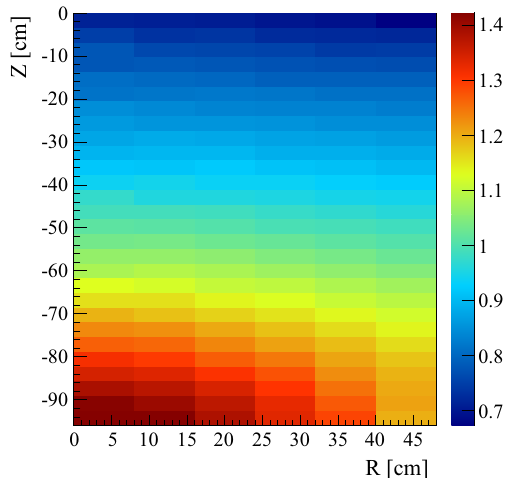
Fig. 21 Azimuthallyaveragedlightcollectionefficiencyrelativetothe mean light yield across the XENON1T TPC. The variation is mainly causedbysolid-angleeffectsandlight-reflection.Theefficiencyismax- imal right above the center of the bottom PMT array and minimal below the outer ring of the top PMT array Light signal The light collection efficiency in the active TPC